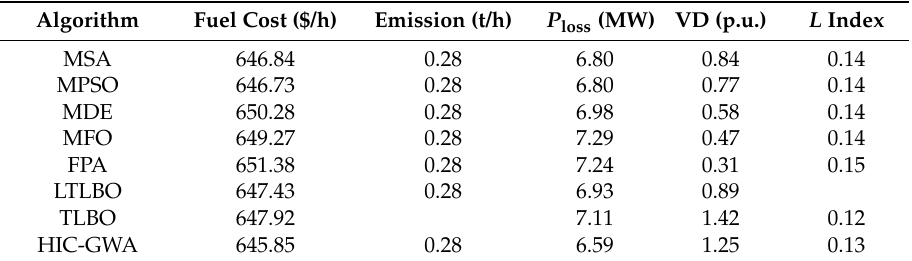
Table 6. Comparison of HIC-GWA with the literature for case study 2.